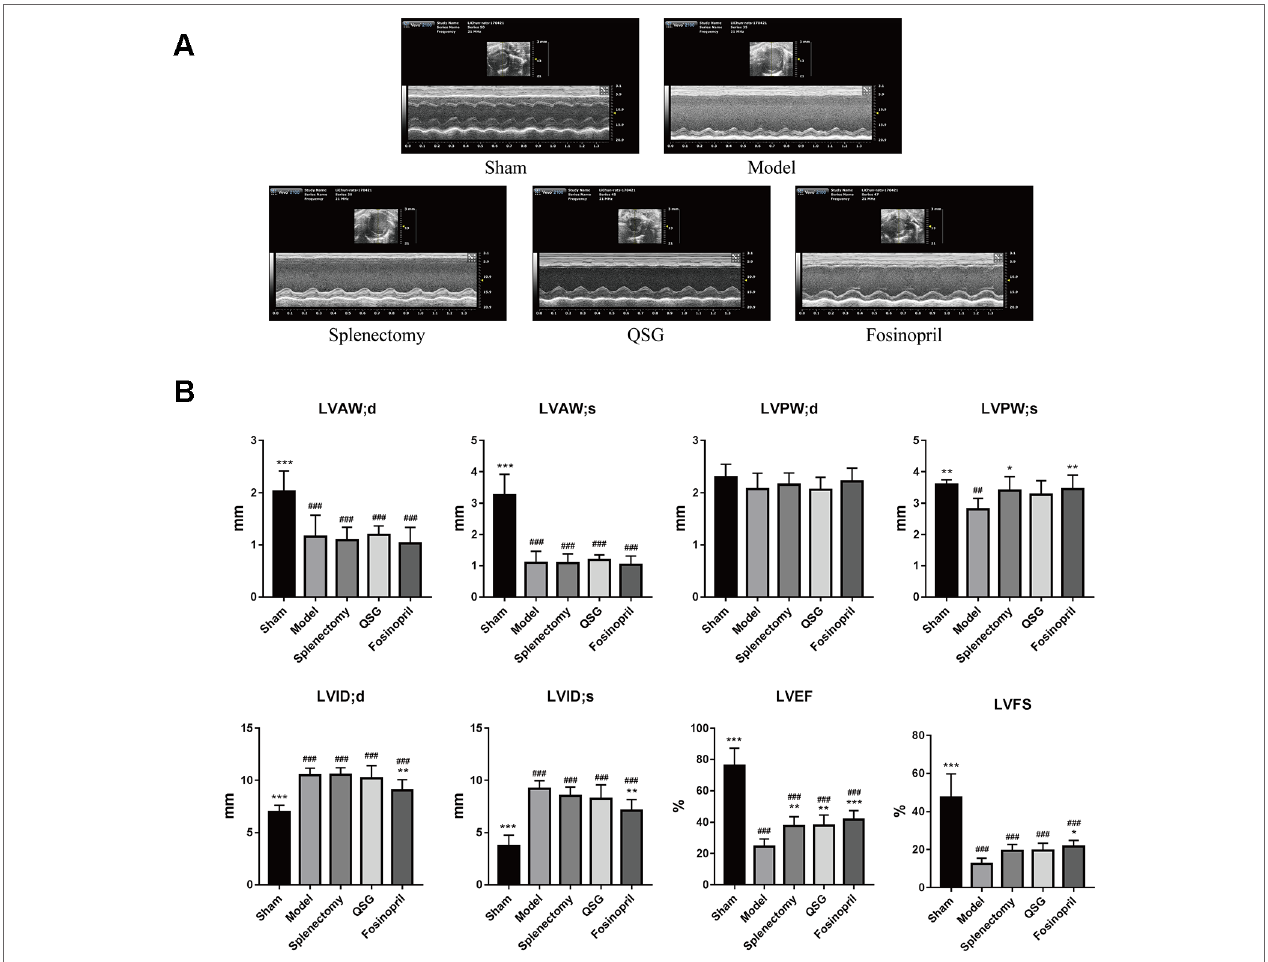
FIGURe 4 | QSG improves cardiac function by echocardiography. (a) Representative images of echocardiography exhibiting the changes in cardiac function in each group. (B) Echocardiography results showed that QSG and splenectomy improved left ventricular ejection fraction, and cardiac function of HF rats. ## P <